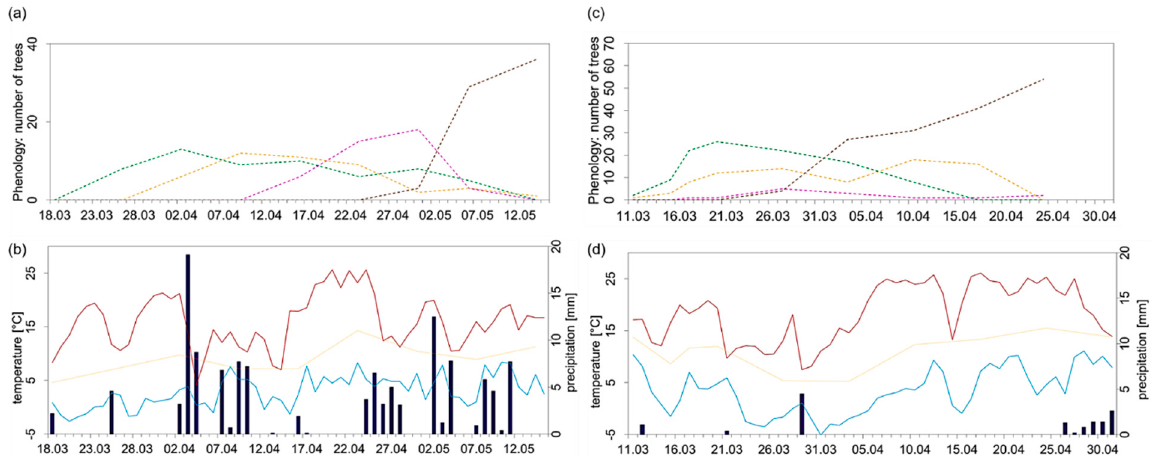
Figure 8. Phenological observations in relation to temperature [°C] and precipitation [mm] during the ash flowering at the location Emmendingen in 2019 ( a , b ) and 2020 ( c , d ). ( a , c ) Phenological observations: BBCH 60 + 61—beginning of pollen release: max. 10% of flowers release pollen (dashed green line); BBCH 65—full flowering: >50% of flowers release pollen (dashed orange line); BBCH 68—end of flowering and pollen release (dashed pink line) and BBCH 69—no more pollen release (dashed brown line). ( b , d ) daily maximum (red line) and minimum (light blue line), and mean (yellow dotted line) of temperature (°C) and daily precipitation sum [mm] (dark blue bars).